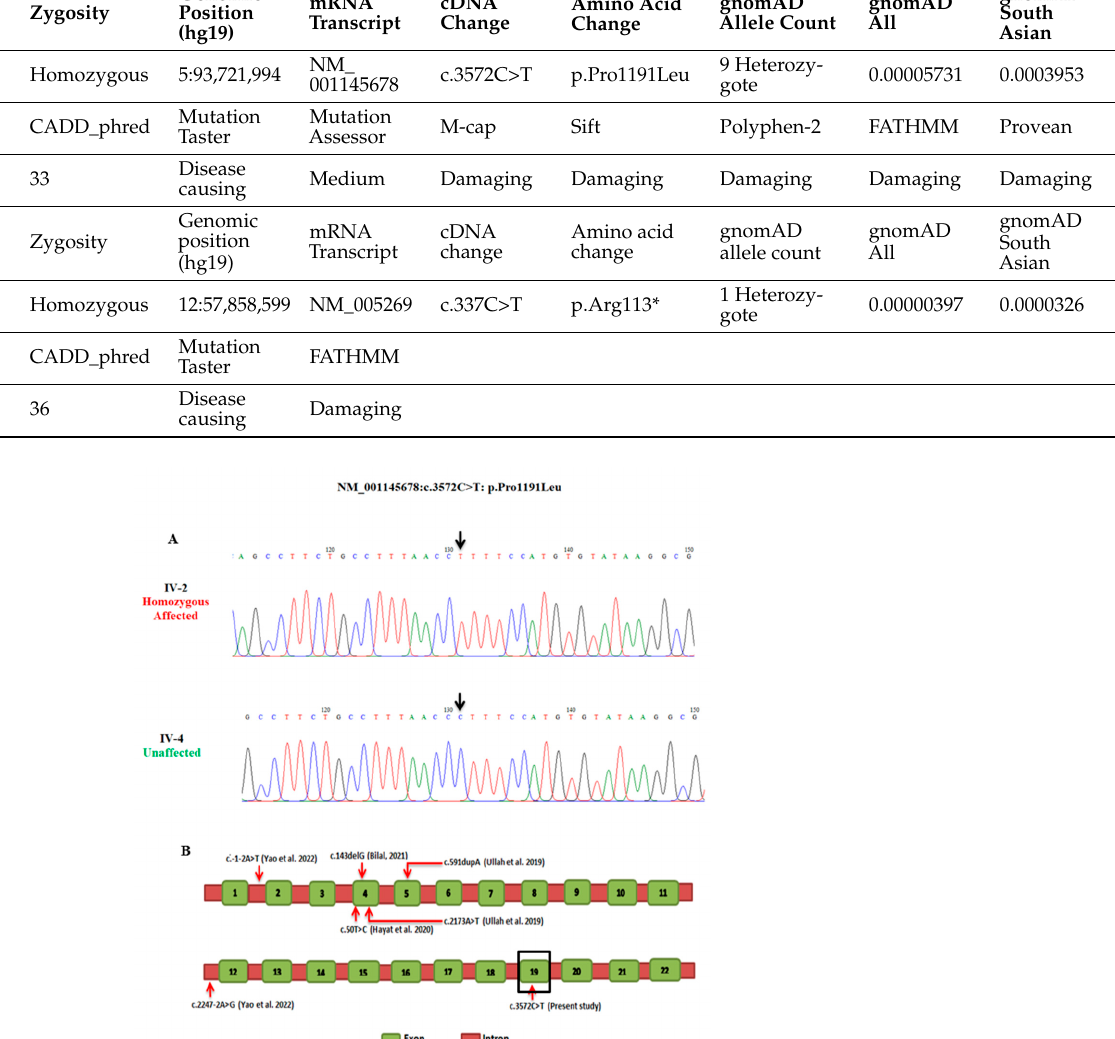
Figure 2. Sequence chromatogram of exon 19 of KIAA0825 . Panel ( A ) presents individual IV-2 as homozygous affected and IV-4 as homozygous wild type. Arrow highlights the position of the substitution mutation (c.3572C>T: p.Pro1191Leu). Panel ( B ) presents a schematic diagram of the KIAA0825 gene structure showing exons. Red arrows indicate the position of mutations reported in polydactyly to date. Variant found in the present study is marked in black square.